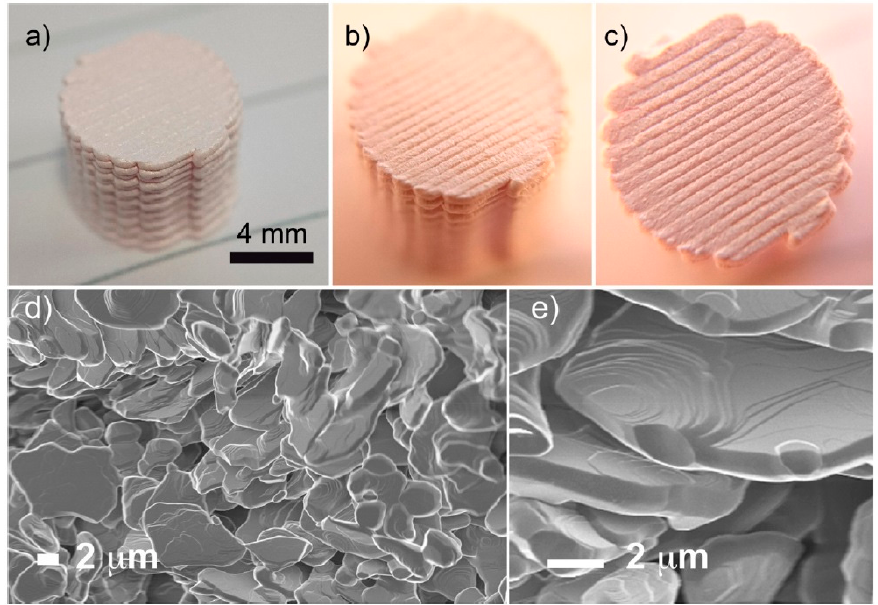
Figure 26. Cylinder printed by DIW from GO/Al 2 O 3 platelets paste and sintered at 1550 °C. ( a − c ). The SEM images show the cylinder microstructure with open porosity of 60% determined by Archimedes’ Principle ( d ) and ( e ). Reproduced from [29], with permission from American Chemical Society, 2017.